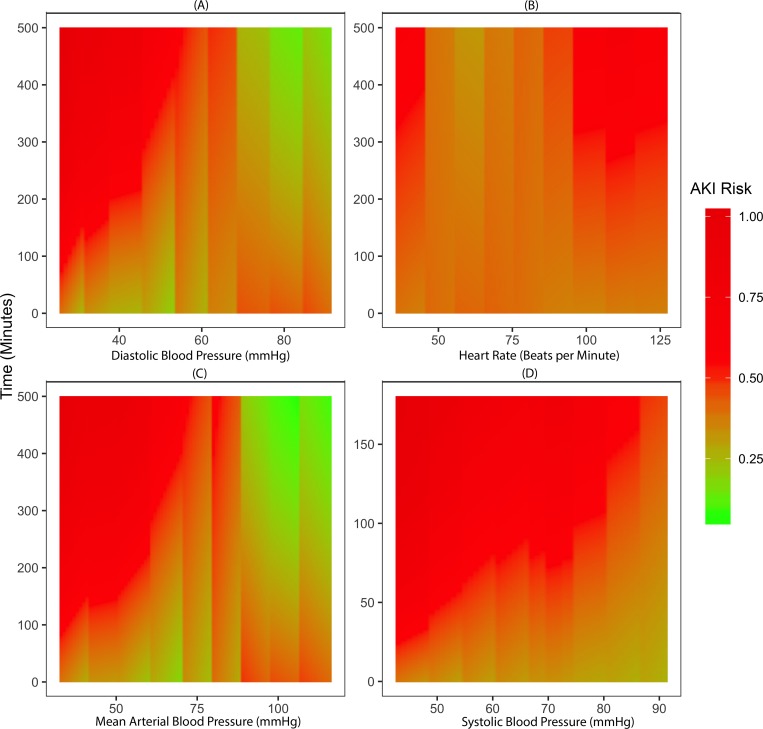
Association between risk of postoperative acute kidney injury and magnitude and duration of intraoperative physiological variations.The risk for the development of postoperative acute kidney injury (AKI) within the first seven days after surgery, as predicted by the postoperative stacked model, was aggregated across the entire cohort. The color represents the risk of developing postoperative AKI, where red is high-risk, and green is low-risk. The y-axis is time (minutes) and the x-axes are (A) diastolic blood pressure (mmHg), (B) systolic blood pressure (mmHg), (C) Mean arterial blood pressure (mmHg), and (D) Heart rate (beats/minute).